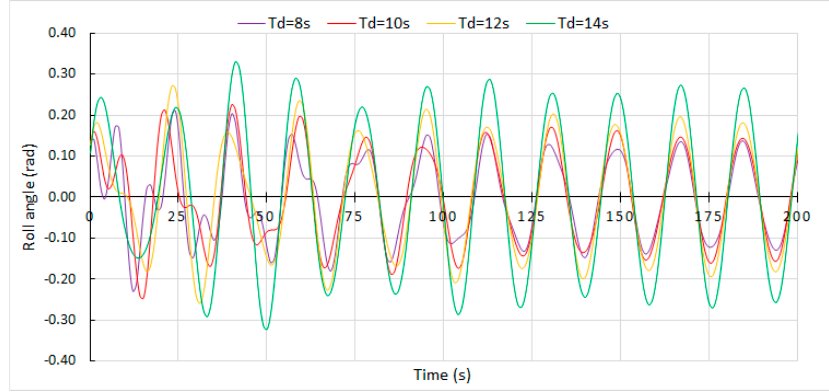
Figure 4. Rolling angles reached by di ff erent ship loading conditions for Tw = 18 s.